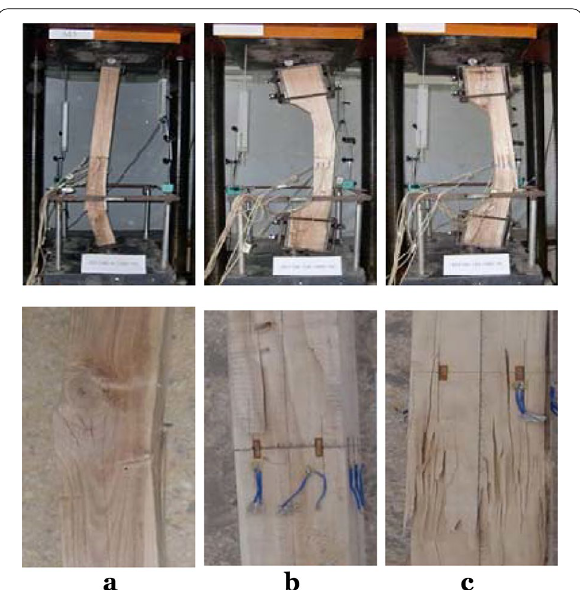
Fig.5 The failure form of DBZ with different initial eccentricities with a 0 mm, b 50 mm, and c 100 mm Fig.6 Load–strain diagram of DBZ under different